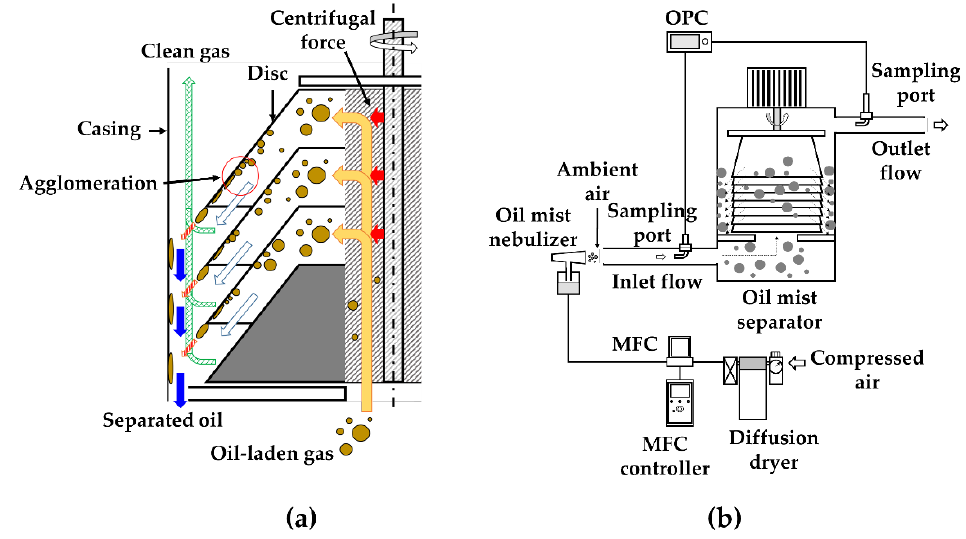
Figure 3. Schematics of: ( a ) disk-stack oil separator (showing the working principle); ( b ) experimental setup for performance testing.